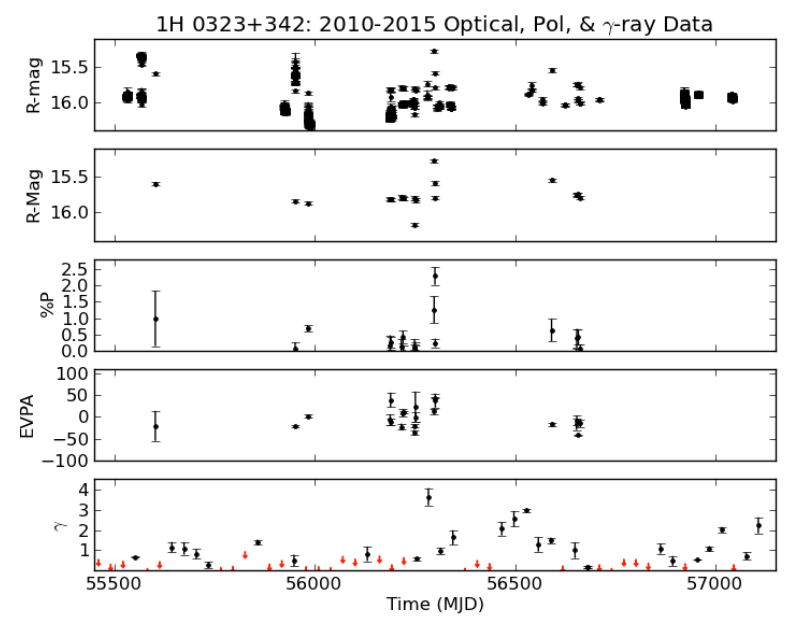
Figure 2. Quasi-simultaneous gamma-ray and optical R-band data for 1H 0323+342.